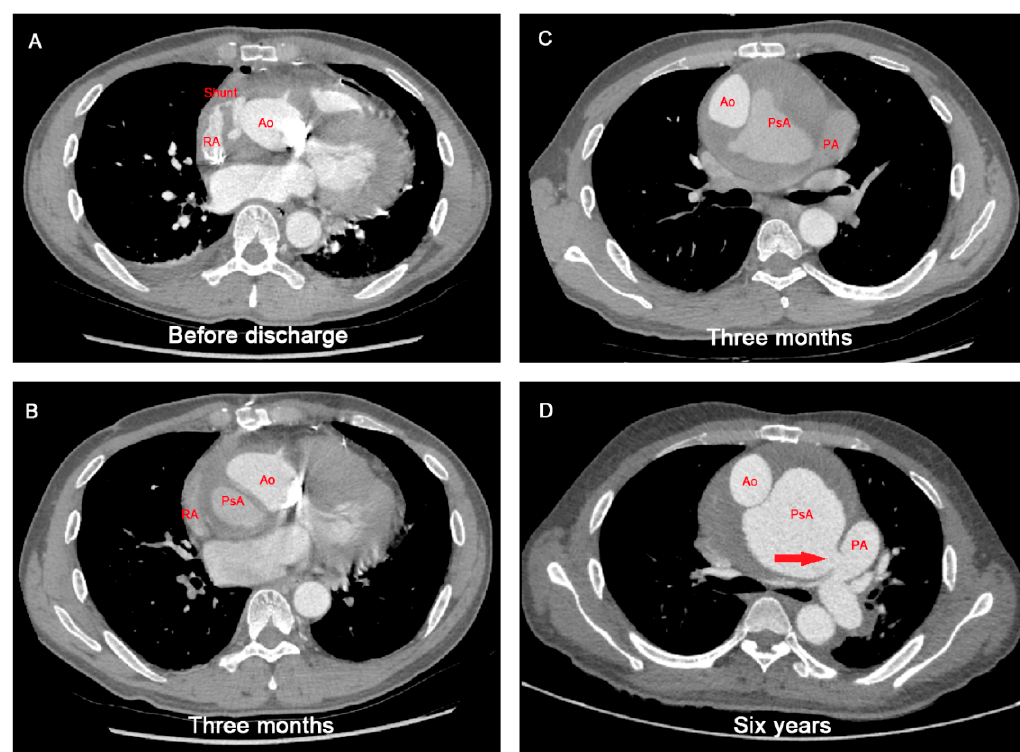
Figure 1. Aortic computed tomographic angiography scan showing the pathogenetic course of pseudoaneurysm and aortopulmonary fistula after Bentall procedure. ( A ) A patent Cabrol shunt after the initial Bentall procedure. ( B , C ) Cabrol shunt obliteration and pseudoaneurysm formation 3 months after the initial Bentall procedure. ( D ) Aortopulmonary fistula formation 6 years after the initial Bentall procedure. Ao: aorta; PA: pulmonary artery; PsA: pseudoaneurysm; RA: right atrium; red arrow indicates the aortopulmonary fistula.